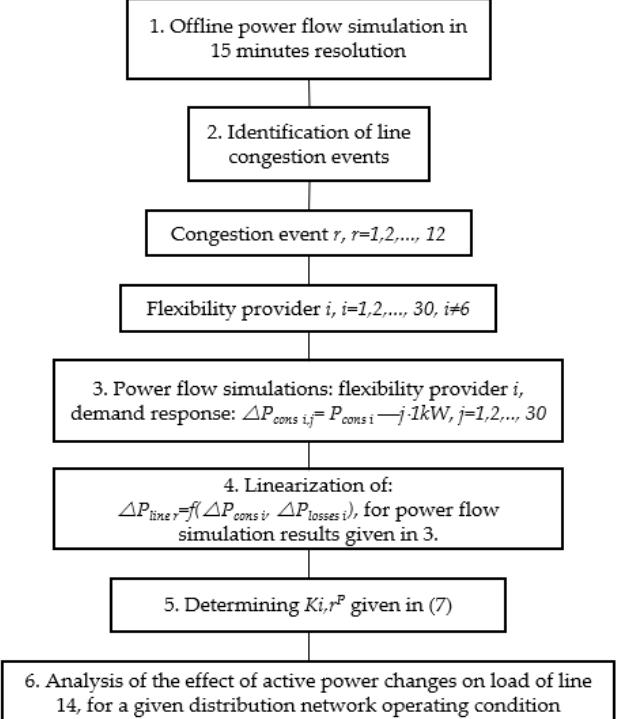
Figure 4. Algorithm for investigating impact of change in active power consumption of flexibility provider/asset on change in load of a congested line.